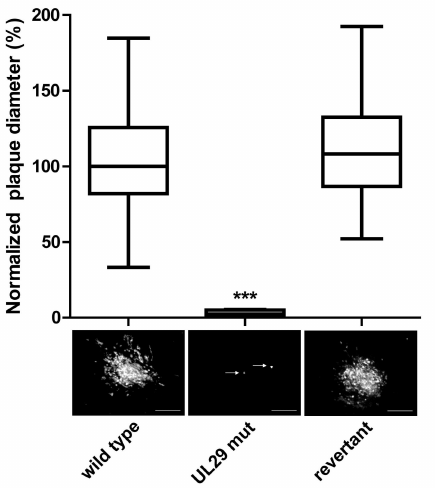
Figure 2. Characterization of the UL29 mutant virus. Wild type, UL29 mut, and revertant BACs were transfected into CEC cells and images of plaques acquired six days later. The average plaque diameters from three independent experiments are shown in a box plot (normalized to wild type) Representative images of plaques are shown below (scale bar, 100 µ m). White arrows indicate single infected cells. Statistical differences in plaque diameters were determined using one-way ANOVA analyses (***, p <